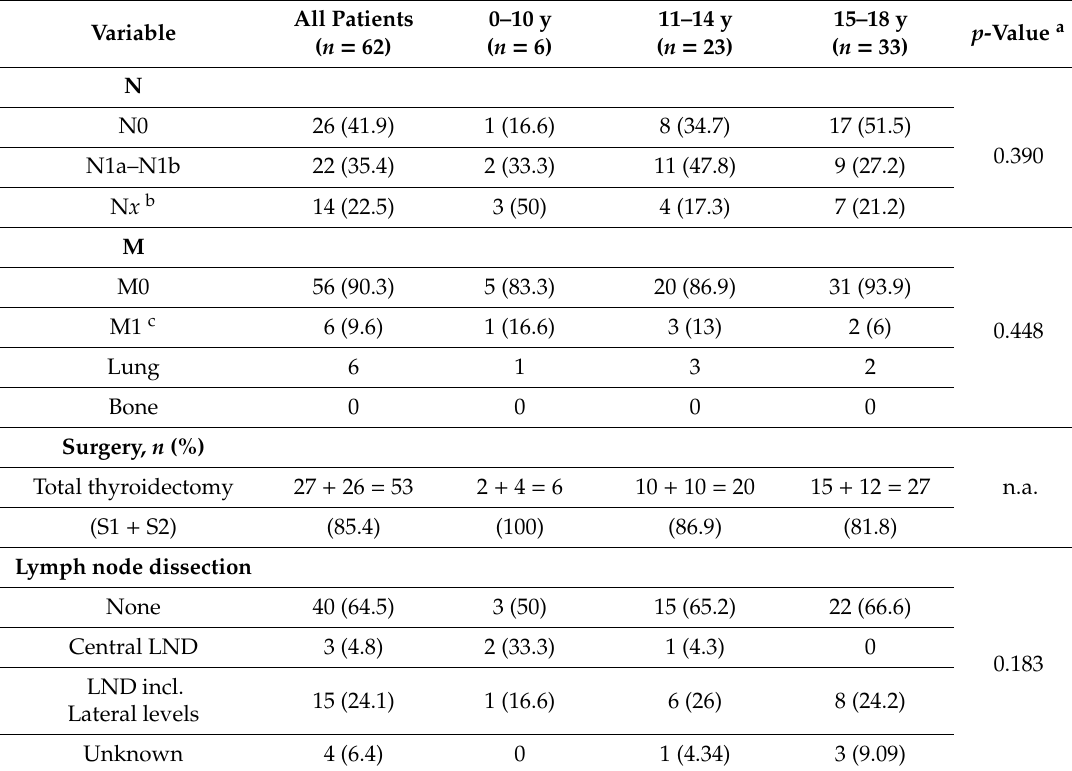
Table 2. Baseline